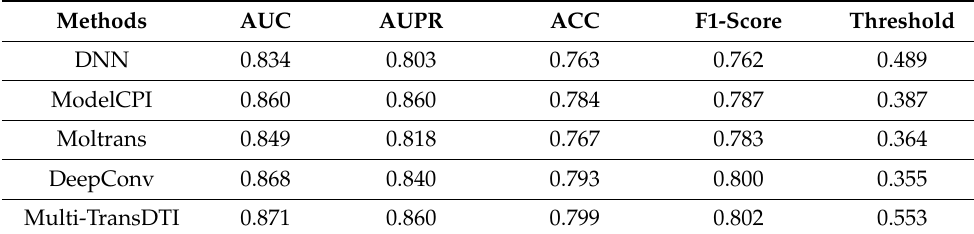
Table 5. Comprehensive performance of different models on 30%